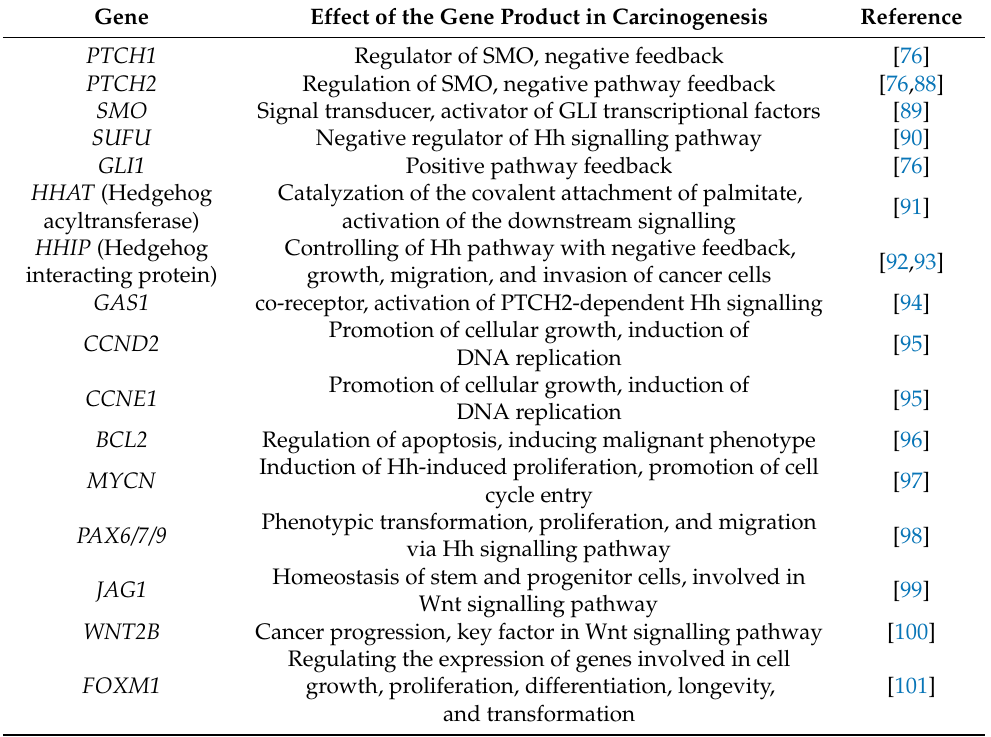
Table 1. Hh signalling pathway related and targeted genes, the most crucial in oncogenesis and signalling. Gene Effect of the Gene Product in